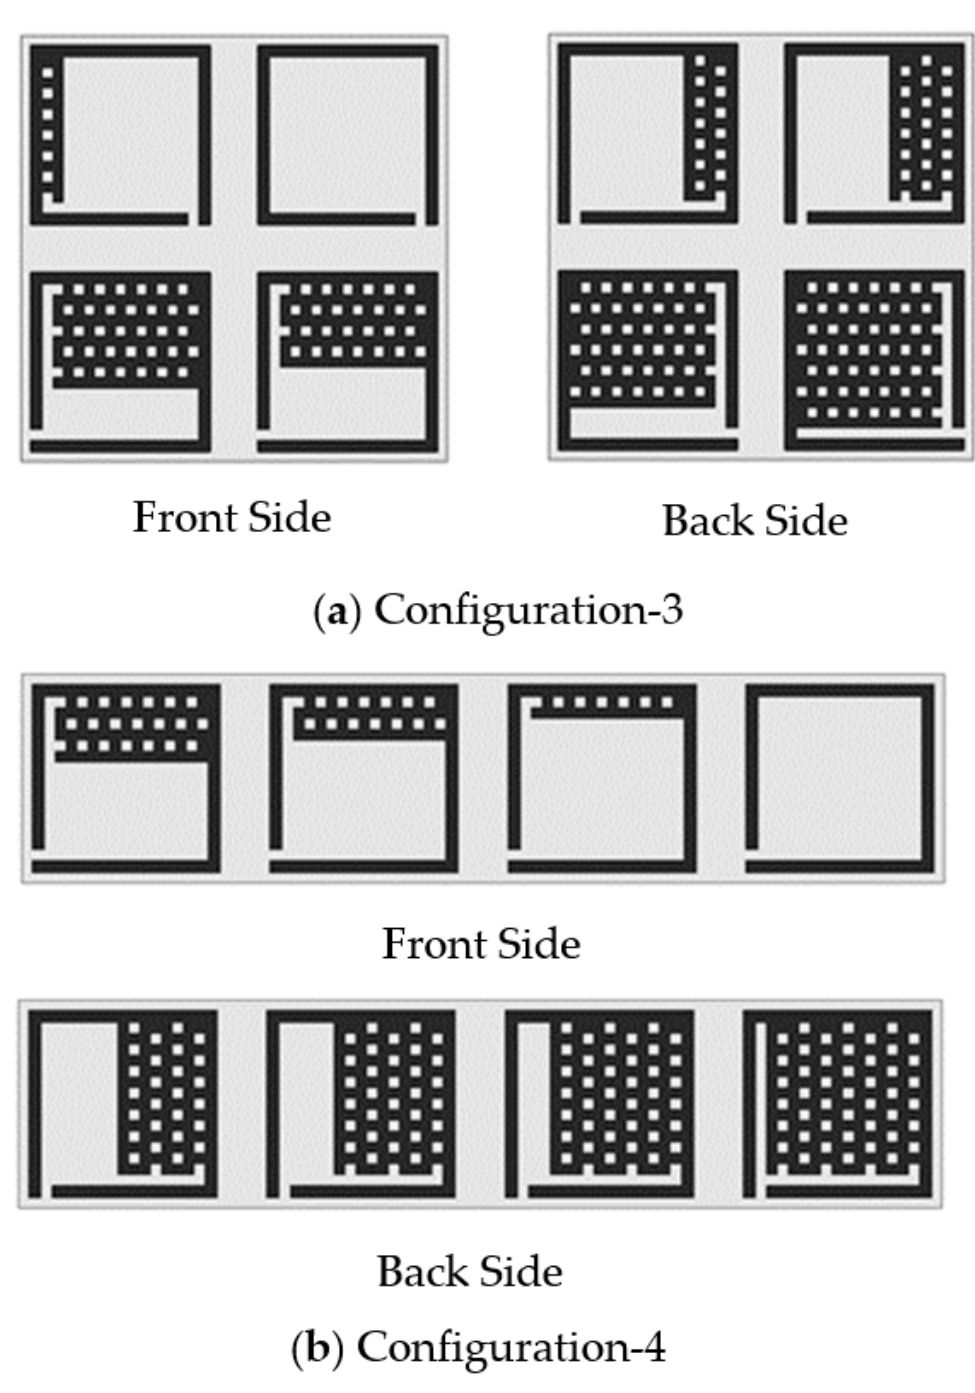
Figure 8. Configuration setting with loaded open-loop resonators on the front and backside of the substrate: ( a ) Configuration-3 (2 × 2 matrix); ( b ) Configuration-4 (4 × 1 matrix).